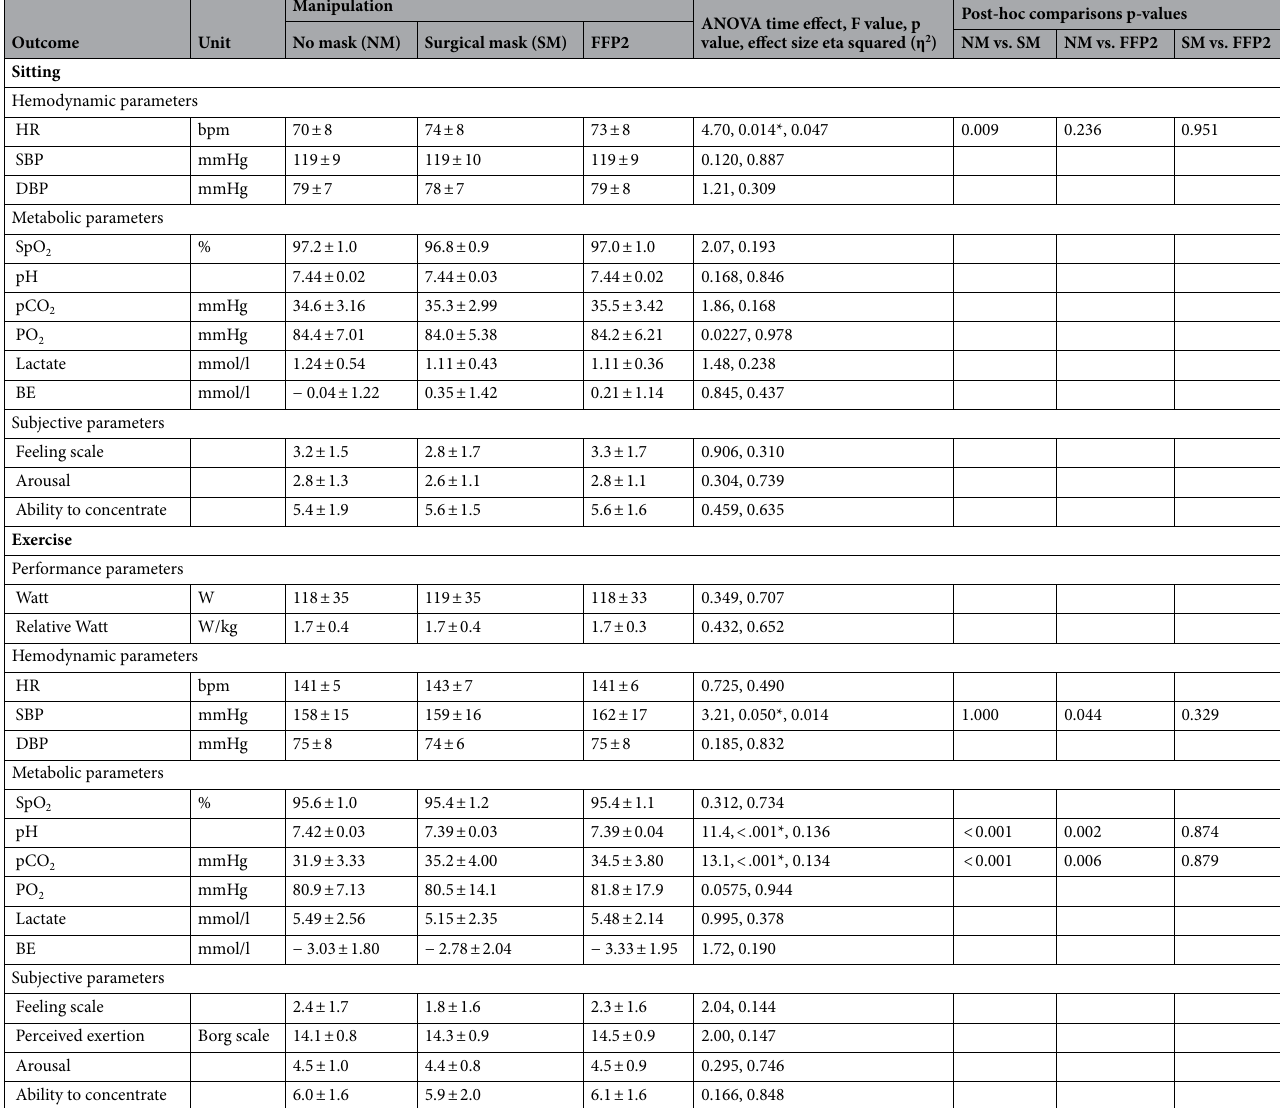
Table 2. Results of hemodynamic, metabolic, subjective and performance outcomes during the sitting and bicycle ergometer intervention with no mask (NM), surgical mask (SM) or filtering face piece (FFP2) application. Significant effects of mask condition are indicated with asterisks (*). HR heart rate, SBP systolic blood pressure, DBP diastolic blood pressure, SpO 2 pulse derived oxygen saturation, pCO 2 partial pressure of carbon dioxide, pO 2 partial pressure of oxygen, BE base excess , bpm beats per